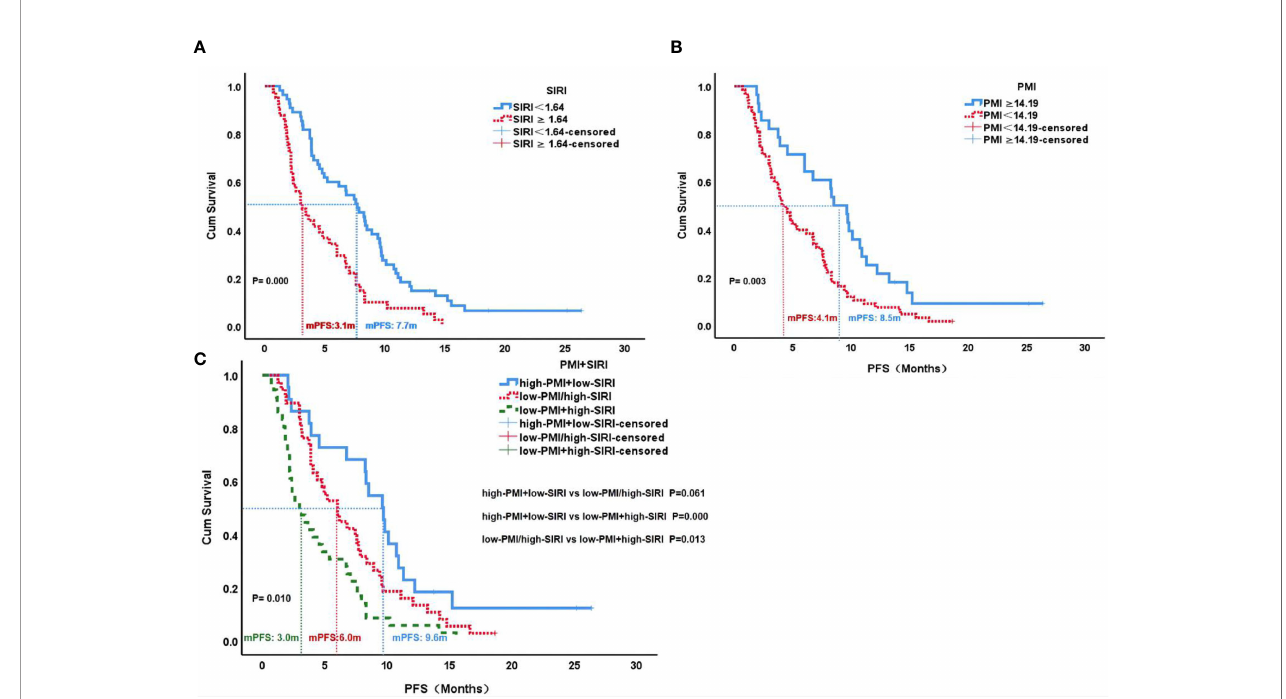
Multivariate Cox Regression Analyses for PFS and OS